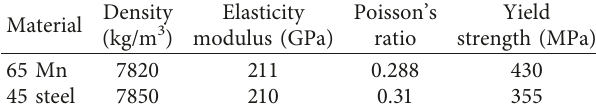
Table 2: Material property parameters of 65 Mn and 45 Steel. Density Material (kg/m 3